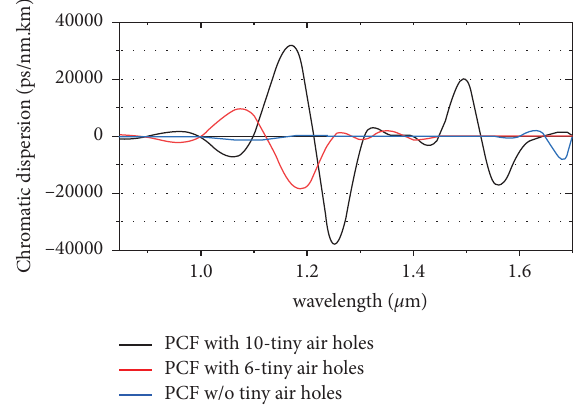
Figure 8: Chromatic dispersion, D ( λ ) as a function of wavelength for the PCFs with the inclusion of tiny air holes. Te pitch ( Λ ) was kept constant at Λ � 2.2 μ m and wavelength ( λ ) at λ � 1.55 μ m for all PCFs.